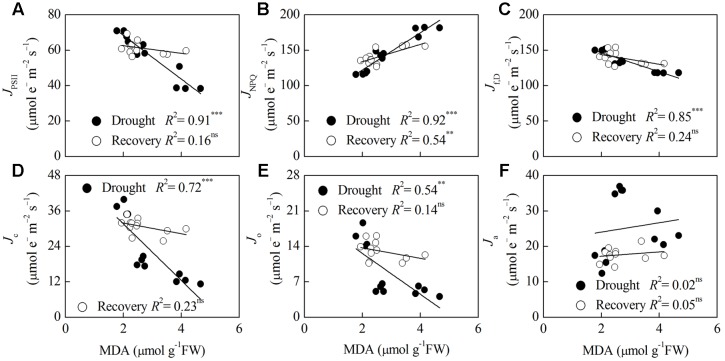
Relationship between lipid peroxidation (MDA) and different energy partitioning processes in F. rufa leaves under drought and rewatering. The regression lines are: (A)
y = –12.31x + 92.98, (B)
y = 26.33x + 69.35, (C)
y = –13.46x + 173.50, (D)
y = –9.60x + 50.89, (E)
y = –4.03x + 20.69, (F)
y = 1.32x + 21.40 (for drought); and (A)
y = –2.17x + 66.90, (B)
y = 12.19x + 109.43, (C)
y = –6.84x + 157.44, (D)
y = –1.82x + 35.60, (E)
y = –1.04x + 15.79, (F)
y = 0.61x + 16.00 (for rewatering). Data are measured values of four replicates per treatment at the same stage (error bars are omitted for clarity). The solid lines represent the best-fit linear regressions: ∗∗P < 0.01; ∗∗∗P < 0.001; ns, not significant.